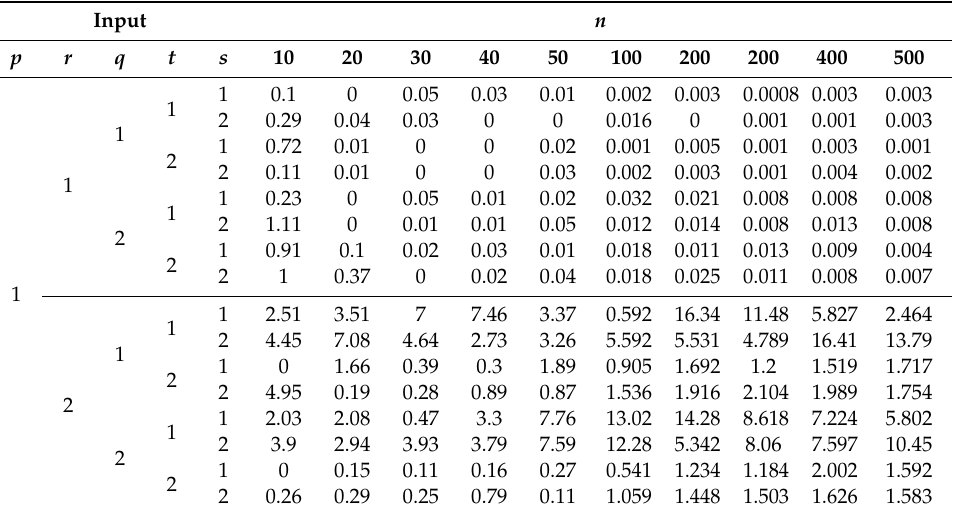
Table 8. Computational results of the